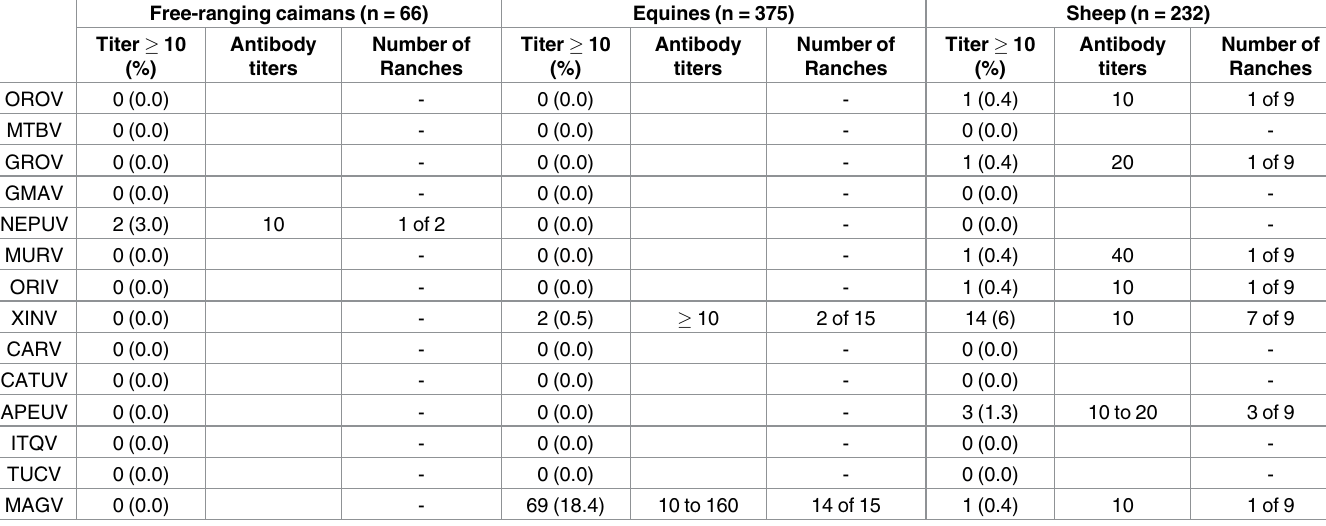
Table 1. Monotypic reactions by PRNT 90 for orthobunyaviruses in caimans, equines and sheep of Pantanal,